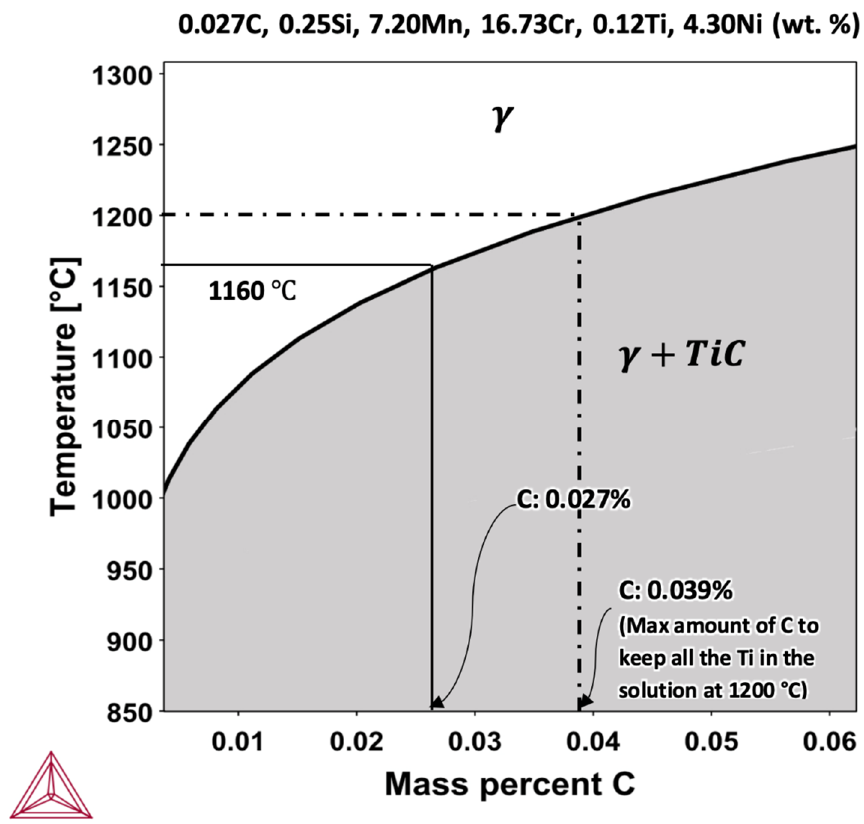
Figure 4. Phase diagram showing Ti solubility in austenite for the studied steel composition (calculated using Thermo-Calc). Table 2. The saturation strain ( ε s ) and Olson–Cohen parameters obtained for 304L, 201L and 201L + Ti steels.